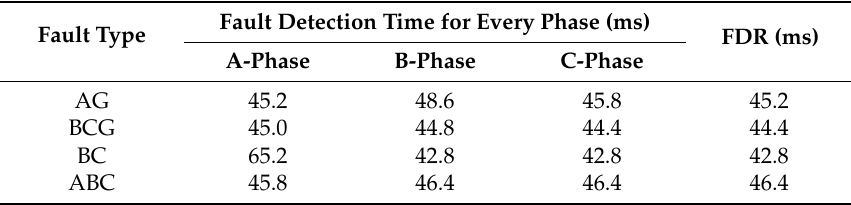
Table 9. Actual short-circuit fault detection results.